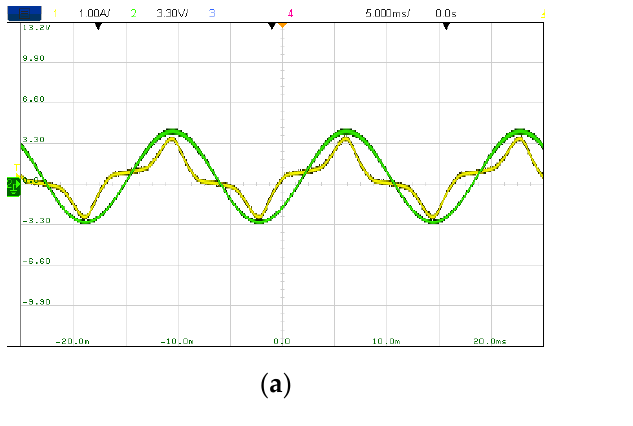
Figure 4. B – H curve plotted by oscilloscope. ( a ) Primary current (yellow) and integration of sec- ondary voltage (green, reversed from the oscilloscope setting) ( b ) B – H curve (without calibration) plotted from ( a ).